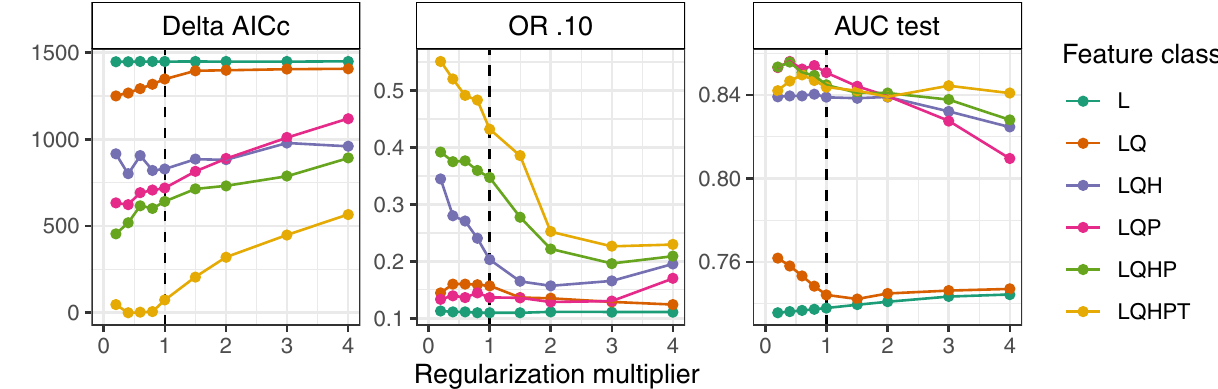
Figure 7. Performance of model candidates evaluated with the indicators Akaike Information Criterion for small samples (AICc), Omission Rate of the testing points at 10% training threshold and Area Under ROC Curve (AUC). The models varied in using feature classes (colour) and the regularisation multiplier (x-axis). The dashed vertical line indicates the default model with a default regularisation of